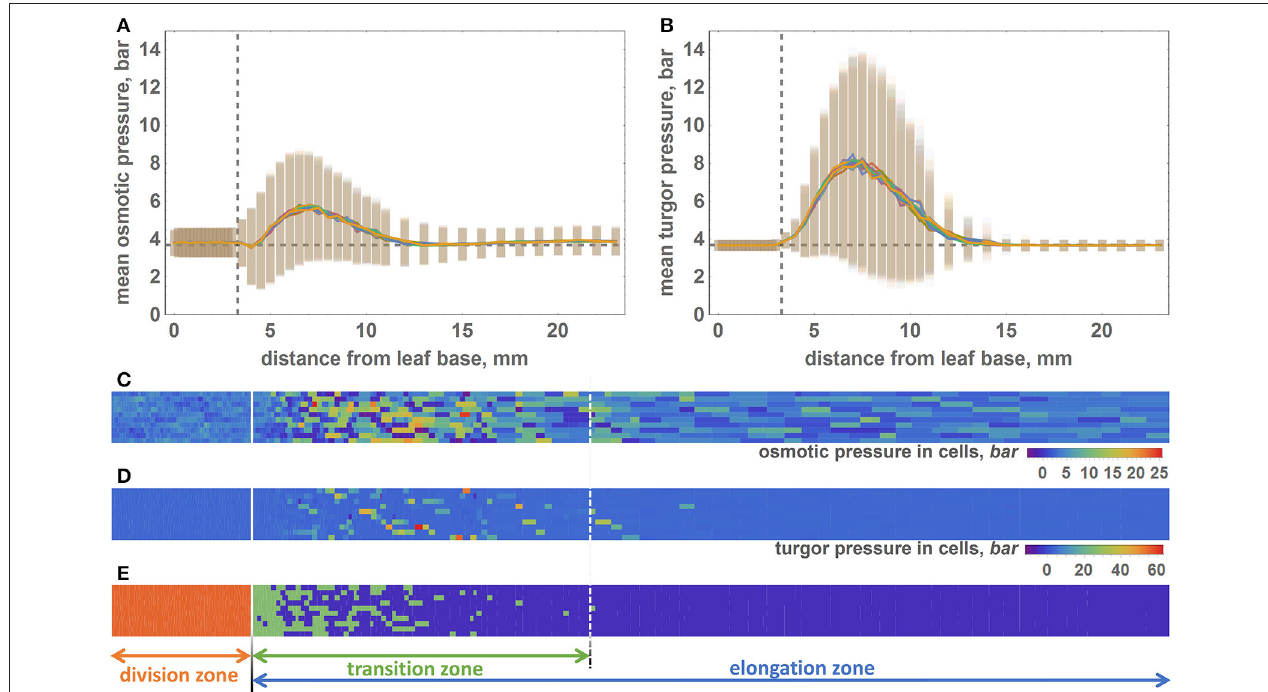
FIGURE 4 | The distribution of the osmotic and turgor pressures in cells along the model leaf axis. (A) Mean values (lines) and standard deviations (vertical bars) of the osmotic pressure (Y axis) in cells with respect to their distance from the leaf base (X axis). Vertical dashed line shows the border between the division and transition zones. Horizontal dashed line shows the equilibrium value of the osmotic pressure. (B) The mean values (lines) and standard deviations (vertical bars) of the turgor pressure (Y axis) in cells with respect to their distance from the leaf base (X axis). Graph notations are the same as in (A) . (C) 2D diagram of the osmotic pressure values for the epidermal cells at the time when the simulation stops. Cells represented by the rectangles, whose sizes are proportional to the cell sizes. The osmotic pressure of the cell shown by rectangle color. The color key is shown at the right bottom part of the diagram. Solid white line is the border between the DZ and TZ regions. Dashed white line is the distal border of the TZ. (D) 2D diagram of the turgor pressure values for the epidermal cells at the time when the simulation stops. The description of the diagram is the same as for (C) . (E) Location of cells of different types in the model leaf epidermis. The cells of different types colored by different colors: red for the DZ cells, green for the TZ cells, and violet for the EZ cells. The division of the leaf into three zones is shown by solid and dashed white lines on the diagram and by arrows below the diagram.